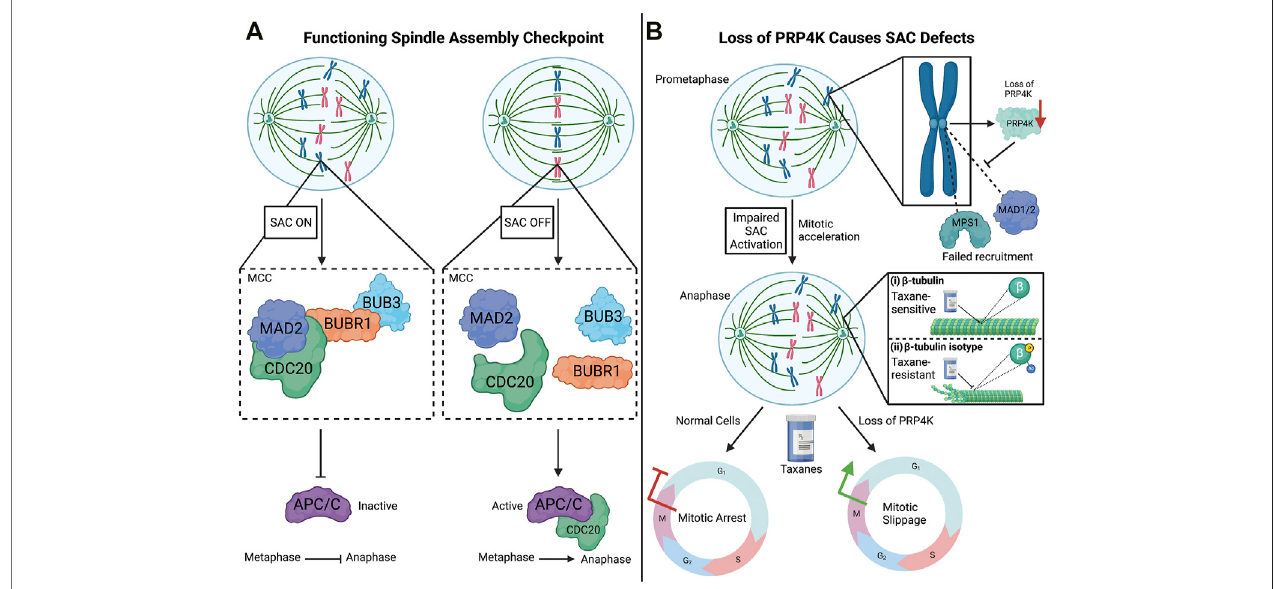
FIGURE2| The spindle assembly checkpoint (SAC) and impact ofPRP4K loss on theSAC. (A) SAC is activated when chromosomesarenot properly attached to thespindlemicrotubulesthroughtheirkinetochores.ThisactivationisdependentontherecruitmentoftheSACproteins,MAD2,CDC20,BUBR1,andBUB3,whichform the mitotic checkpoint complex (MCC) at kinetochores. The binding of SAC target CDC20 to the MCC prevents its association with APC/C (anaphase-promoting complex/cyclosome),whichpromotesthetransitionfrommetaphase toanaphase.Whenchromosomesareproperlyaligned,theassemblyoftheMCCisinhibited turningofftheSAC,whichinturntriggersAPC/CtoassociatewithCDC20andpromotetheonsetofanaphase. (B) LossofPRP4KimpairsSACactivationbyanti-mitotic agentssuch as the taxanes. Normal cells treated with taxanes (anti-mitotic agent) results in mitotic arrest during the mitotic (M) phase, but cells with lowlevels ofPRP4K fail to activate the SAC and undergo mitotic slippage into G1 without chromosome segregation. Mechanistically, loss of PRP4K contributes to taxane resistance by impairing drug-induced recruitment of SAC proteins MPS1 and MAD1/2 to kinetochores to trigger the SAC. In normal cells, taxanes bind the β -tubulin subunit of microtubules and induce dynamicstability, leading tocell death (i). However, both direct post-translational modi fi cation (e.g., phosphorylation or acetylation) of β -tubulin subunitsorchangesintubulinisoformsexpressioncanaltertaxanebindingandcontributetotaxaneresistancebypreventingmicrotubulestabilizationbythesedrugs(ii). Elements of this fi gure were created with